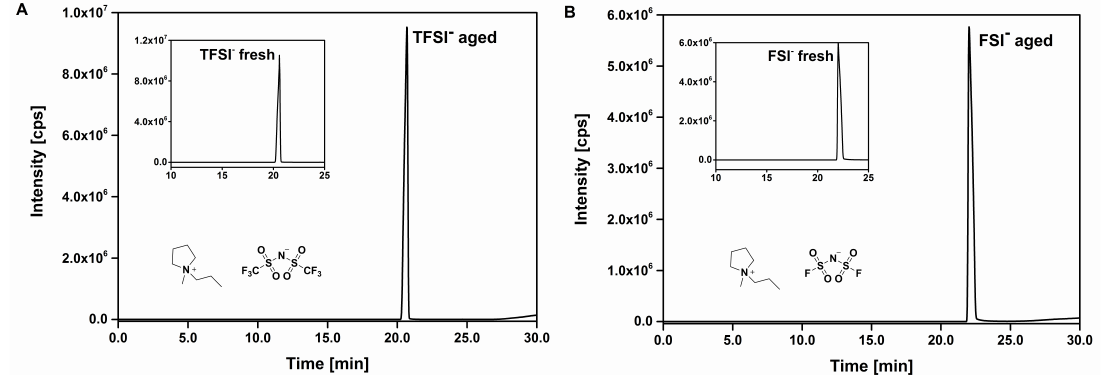
Figure 3. Electropherograms of the detected m/z ratio 279.9173 of the fresh and aged TFSI − sample ( A ) and of the detected m/z ratio 179.9238 of the fresh and aged FSI − sample ( B